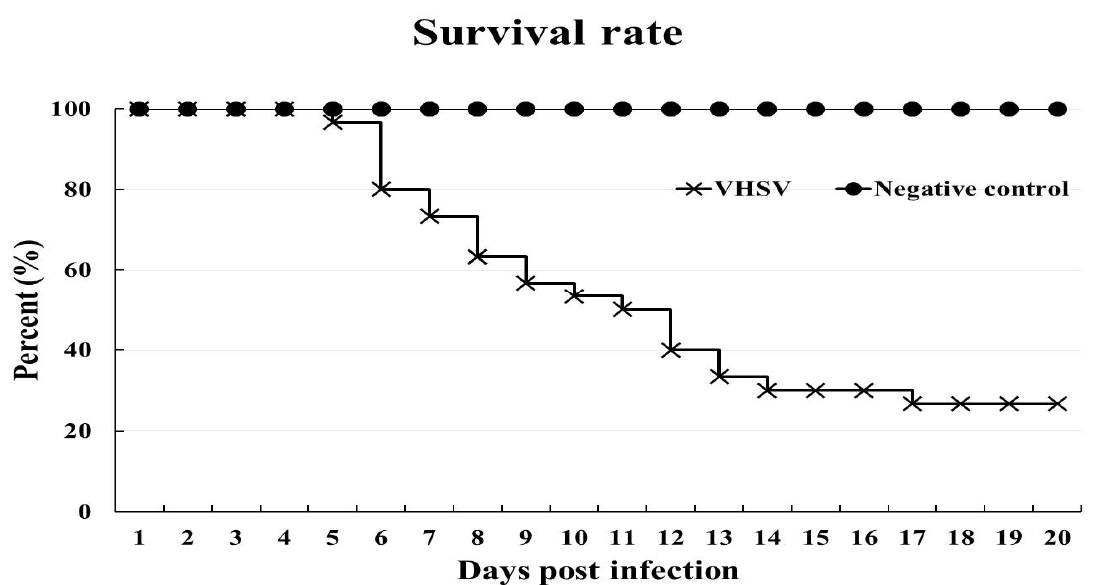
Figure 2. The survival rate of olive flounder after challenge with VHSV. Fish were intraperitoneally injected with VHSV (1 × 10 7 TCID 50 /mL) in the VHSV infection group ( n = 30). These fish had 26% survival while the negative control group ( n = 30) had 100% survival.